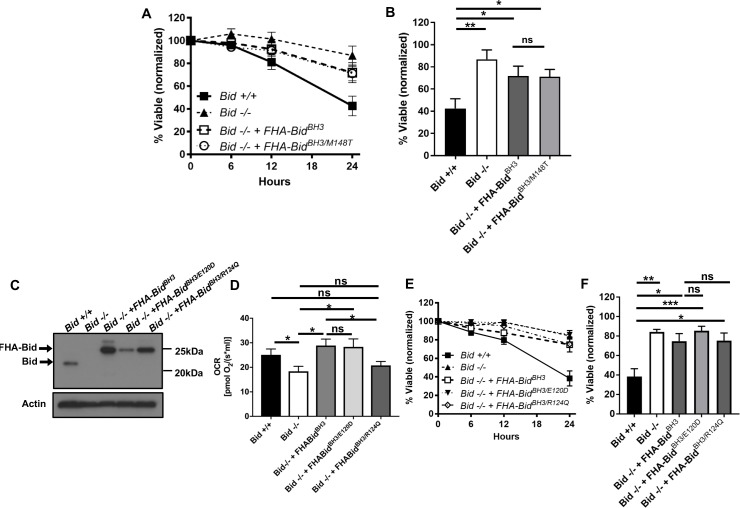
Mutations in Bid corresponding to Helix-5 SNPs show less impact on respiration than Helix-6 mutation M148T.(A) Viability assay (AV/PI) for indicated cell lines corresponding to Figure 8 and (B) the 24 hr time-point (n = 5). (C) Western blot of expression levels of Bid for the indicated genotypes. (D) OCR of Bid-/-, Bid-/- + FHABidBHBH3, Bid-/- + FHABidBHBH3/E120D, and Bid-/- + FHABidBHBH3/R124Q MPCs for all cell lines (n = 4,4,6,6 respectively). (E) Viability assay (AV/PI) of MPCs for indicated times following TNF-α/Actinomycin D treatment and (F) 24 hr timepoint (n = 3,3,3,6,6 respectively). The percent of viable cells was normalized to no treatment. P-values were determined by one-way ANOVA (p<0.05) with Student’s t-test for (B, D) and (F). Error bars indicate ±SEM for all data. ns = not significant, *p<0.05, **p<0.01, ***p<0.001.